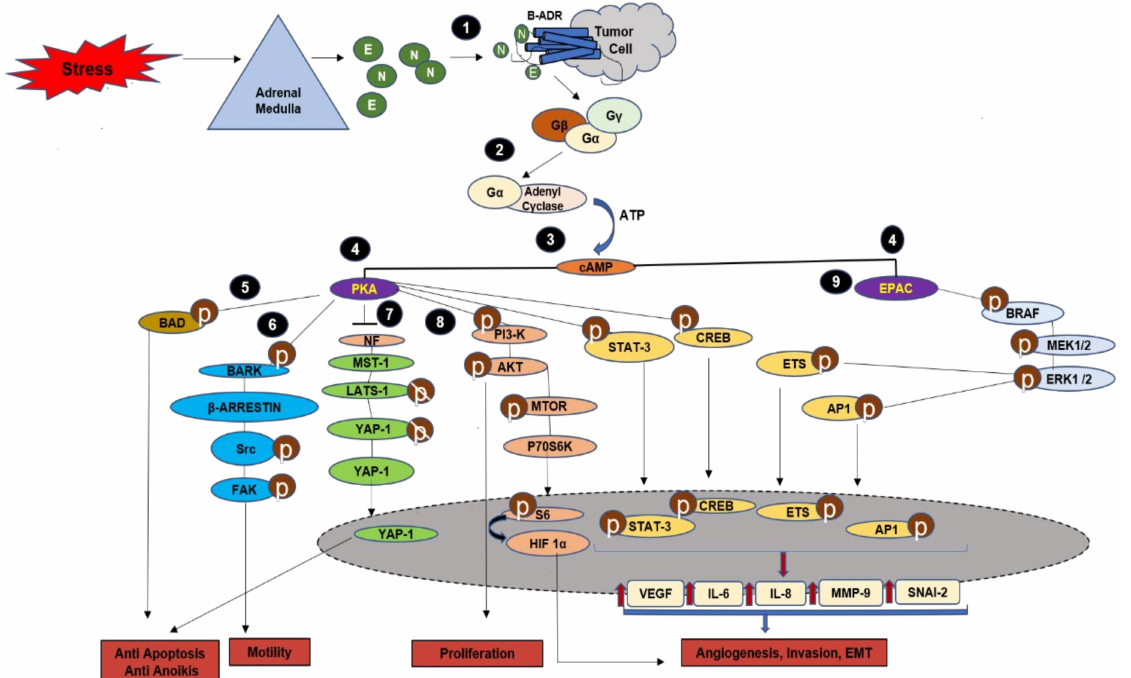
Figure 3. Adrenergic signalling pathway and mechanisms. The binding of Epinephrine (E) and Norepinephrine (N) to β -adrenergic receptors ( β -ADR) results in G α s-mediated activation of adenylyl cyclase ( 1 , 2 ). This causes a transient influx of cyclic AMP (cAMP) ( 3 ). cAMP activates the two effector pathways, Protein Kinase A (PKA) and exchange protein directly activated by cyclic AMP (EPAC) ( 4 ). PKA phosphorylates Bcl-2 associated agonist of cell death (BAD) which makes the cells resistant to apoptosis and anoikis ( 5 ). It also phosphorylates β -adrenergic receptor kinase (BARK) which recruits β -arrestin, further phosphorylating Src and Focal Adhesion Kinase (FAK), resulting in cell motility ( 6 ). In cervical cancer cells, sustained adrenergic signalling that results in PKA activation causes inhibition of the tumour suppressive Hippo Yap pathway. PKA targets the tumour suppressor Neurofibromin 2 (NF-2), as a result of which the downstream phosphorylation of mammalian Ste20-like kinases 1 (MST1/2; homologs of Drososphila Hippo (Hpo)), large 2 tumour suppressor 1 (LATS 1 ; homologs of Drosophila Warts (Wts)) and Yes-Associated Protein (YAP) is inhibited. The 2 2 dephosphorylated YAP translocates into the nucleus and inhibits apoptosis ( 7 ). β -adrenergic receptors activated by stress lead to cAMP-PKA/AKT/mTOR/P70S6K/HIF α pathway-dependent proliferation and angiogenesis ( 8 ). EPAC leads to the activation of BRAF-MAPK signalling pathway ( 9 ). The transcription factors STAT3, CREB, ETS, AP1 are phosphorylated by PKA as well as by EPAC ( 10 ) which upregulate the expression of vascular endothelial growth factor (VEGF), interleukin (IL)-6, IL-8, matrix metalloproteinases (MMPs), SNAI-2 involved in angiogenesis and invasion. Adapted from